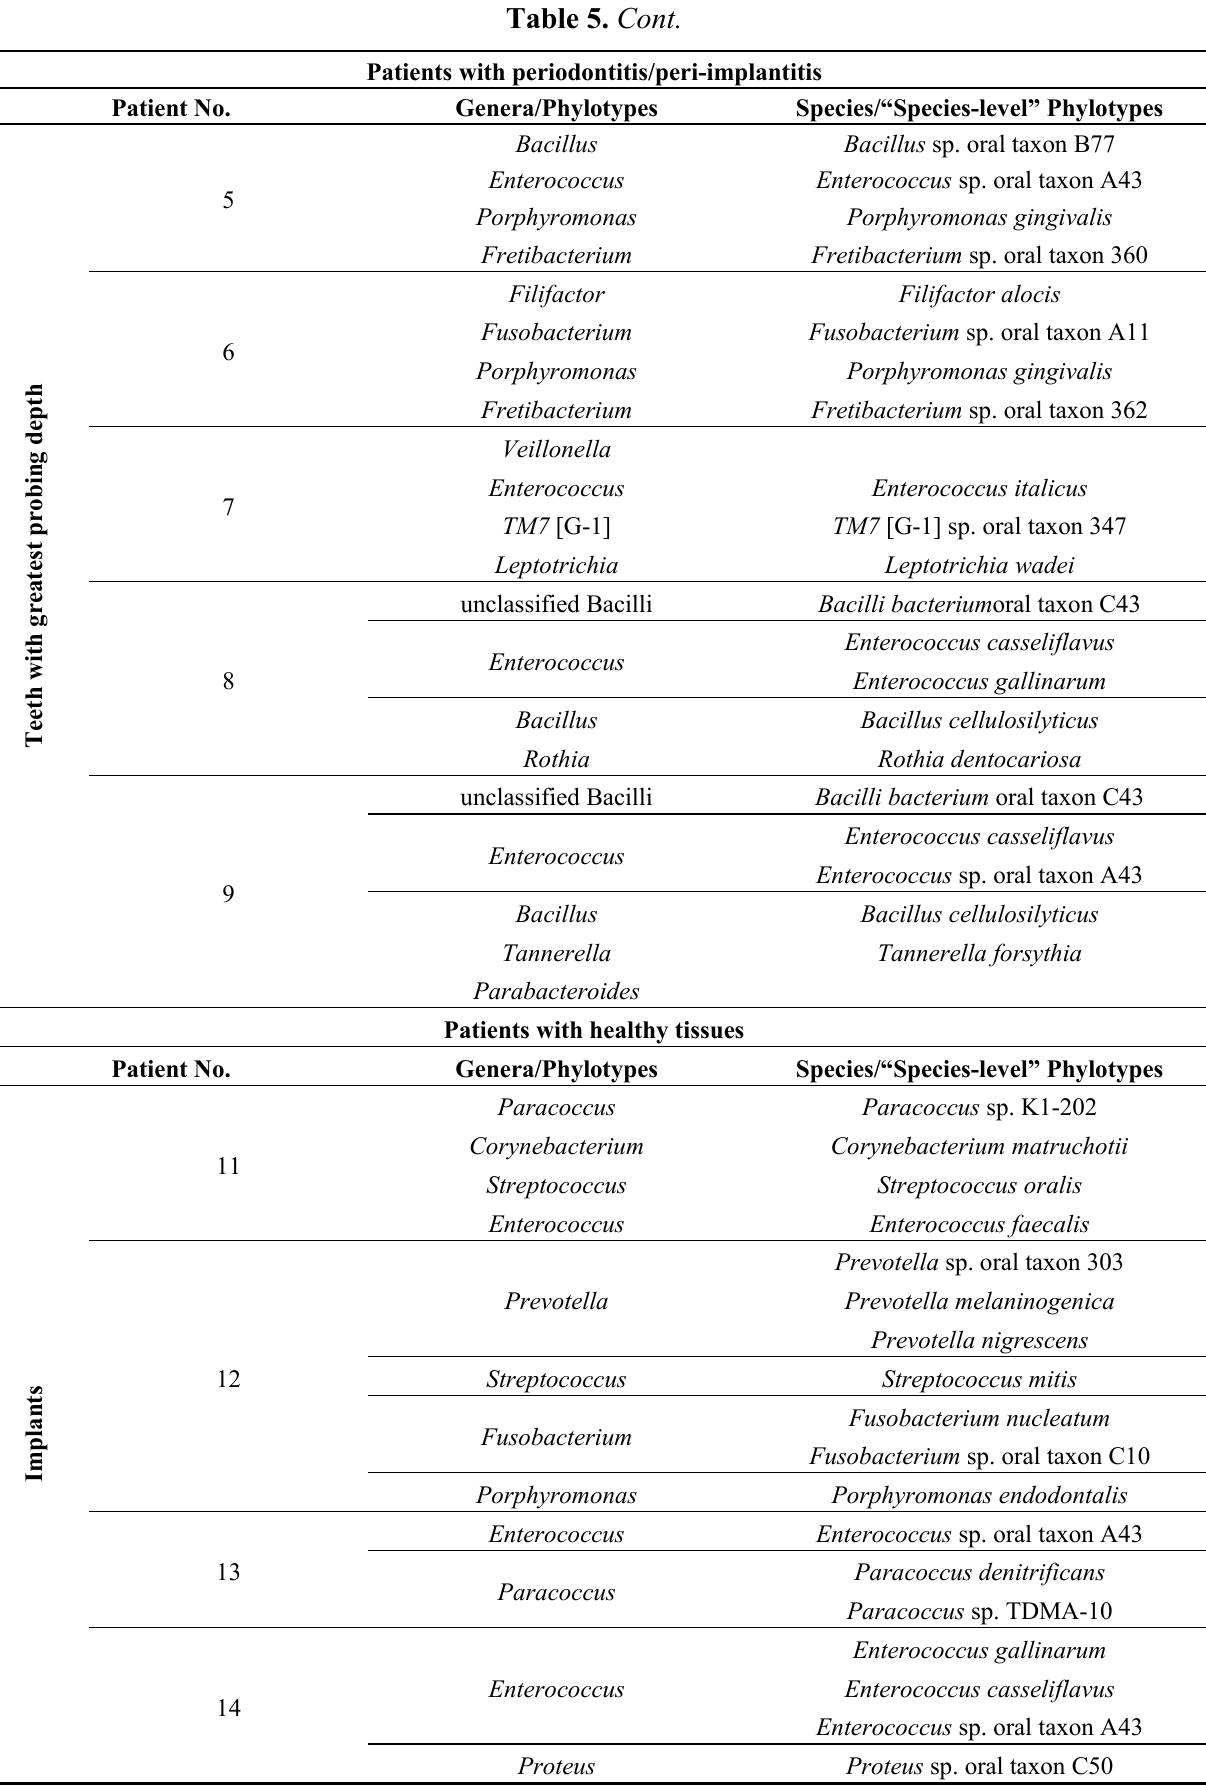
Table 5. Cont. Patients with periodontitis/peri-implantitis